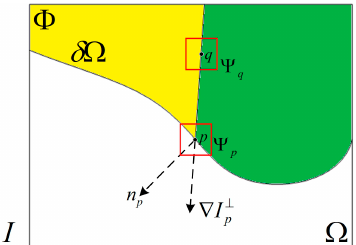
Figure 5. Notation diagram for Criminisi’s algorithm.